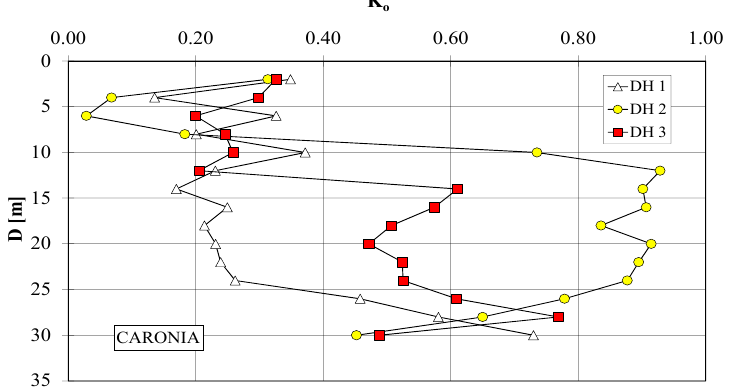
Figure 8. Poisson ratio from down-hole tests.